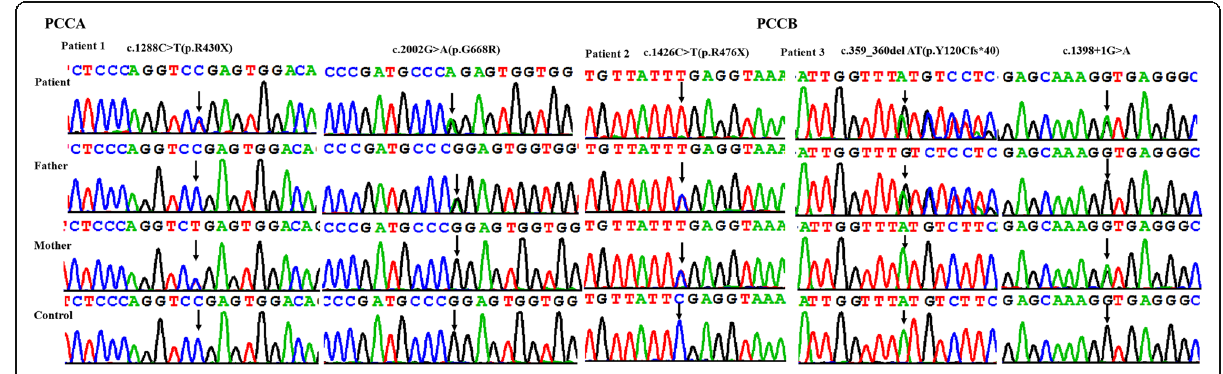
Fig. 1 DNA sequencing result from PCCA (Patient1 – 2) and PCCB (Patient3) gene, changes also seen in the father or/ and mother, but not seen in a representative normal subject. Three novel mutations: c.1288C> T(p.R430X) (PCCA, patientv1); c.359_360delAT(p.Y120Cfs*40) (PCCB, patient 3), c.1398 + 1G > A (PCCB, patient